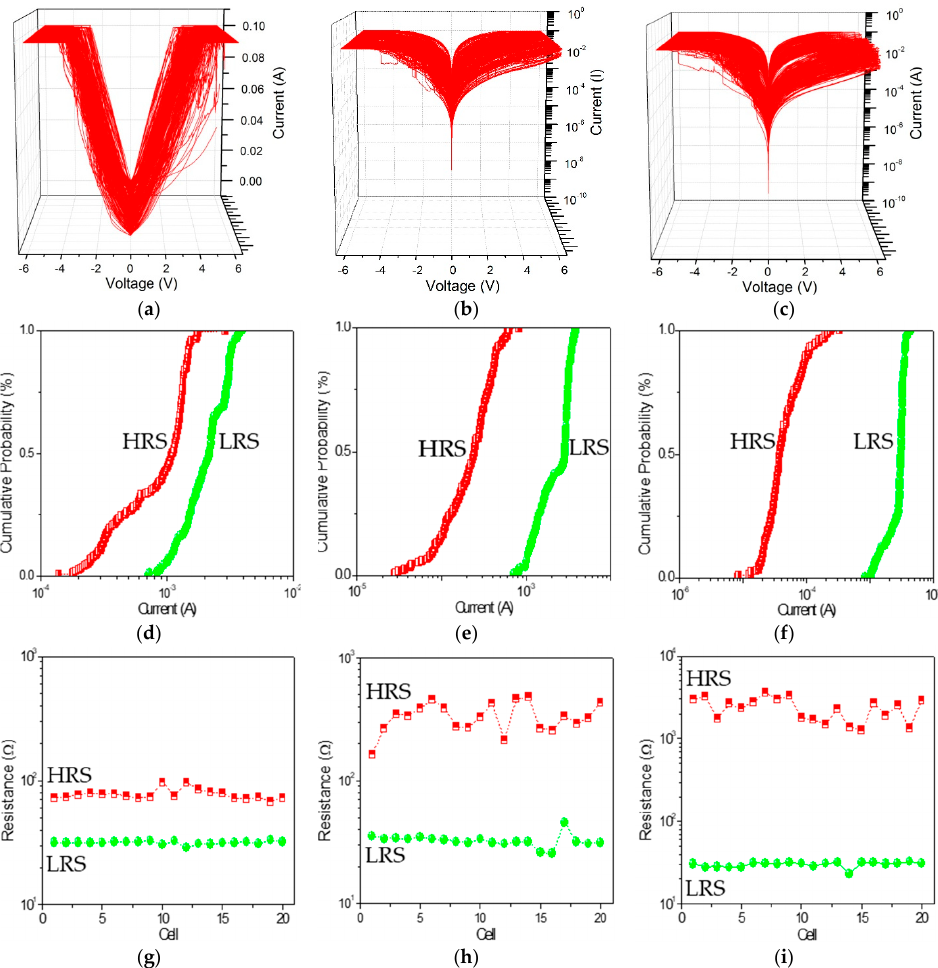
Figure 4. ( a – c ) Endurance cycles, ( d – f ) statistical analysis, and ( g – i ) device-to-device profiles of 20 devices at V read = − 0.1 V with the chemical component ratio of PBD:GO at 2:1, 5:1, and 10:1 w/w.